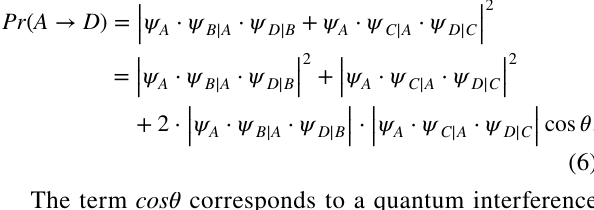
Fig. 1 An example of quantum probability in two dimensions